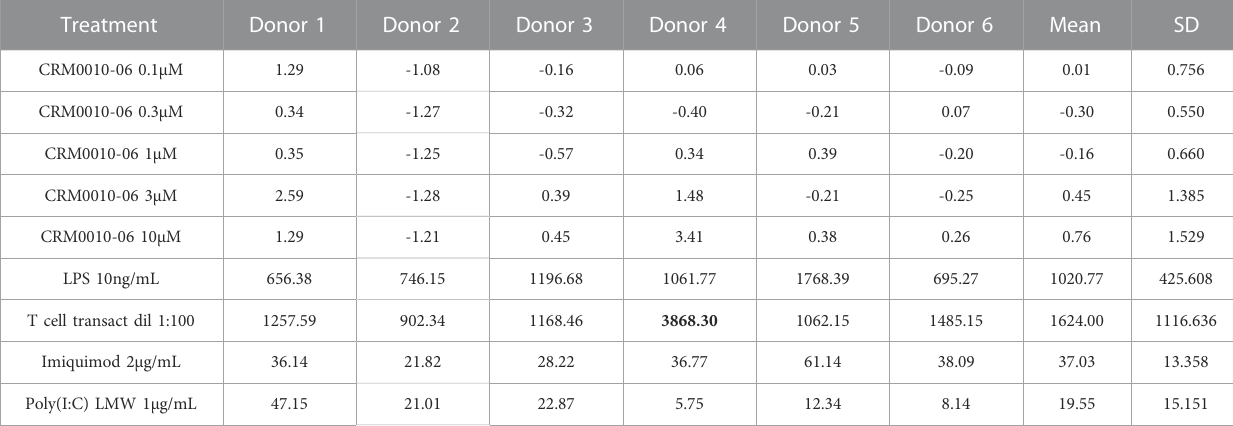
-: Values not quanti fi able. Boldvalues indicates concentrationsabovelimit of quanti fi cation(SAI1 ALQ= 3540.0 and SAI1 ALQ= 3540.0)Grey values indicatesconcentrations belowlimitof quanti fi cation (SAI7 BLQ = 0.9 and SAI7 BLQ =